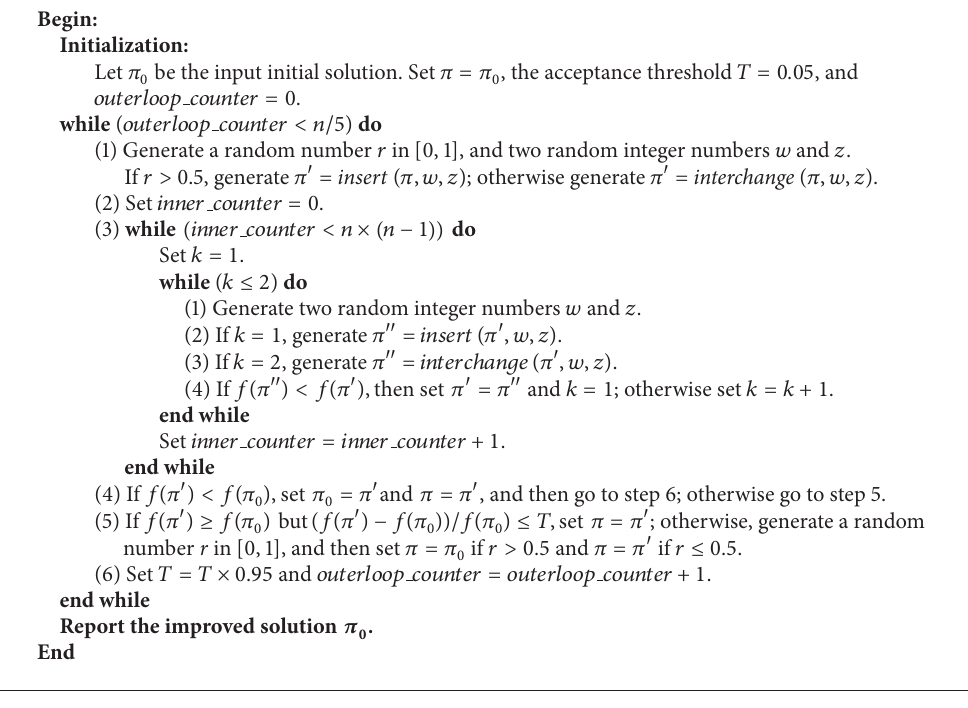
Algorithm 1: The main procedure of the SA VNS